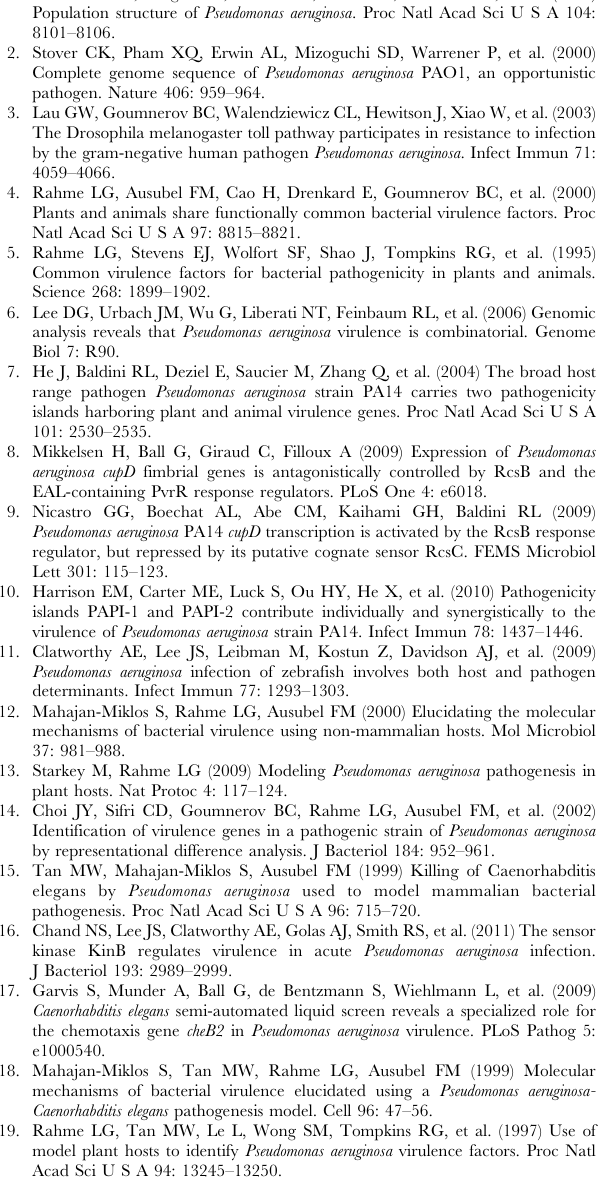
Ausubel, 2008), and viability was scored at the indicated time points. Data is representative of three independent experiments. Table S1 Oligonucleotides used in this